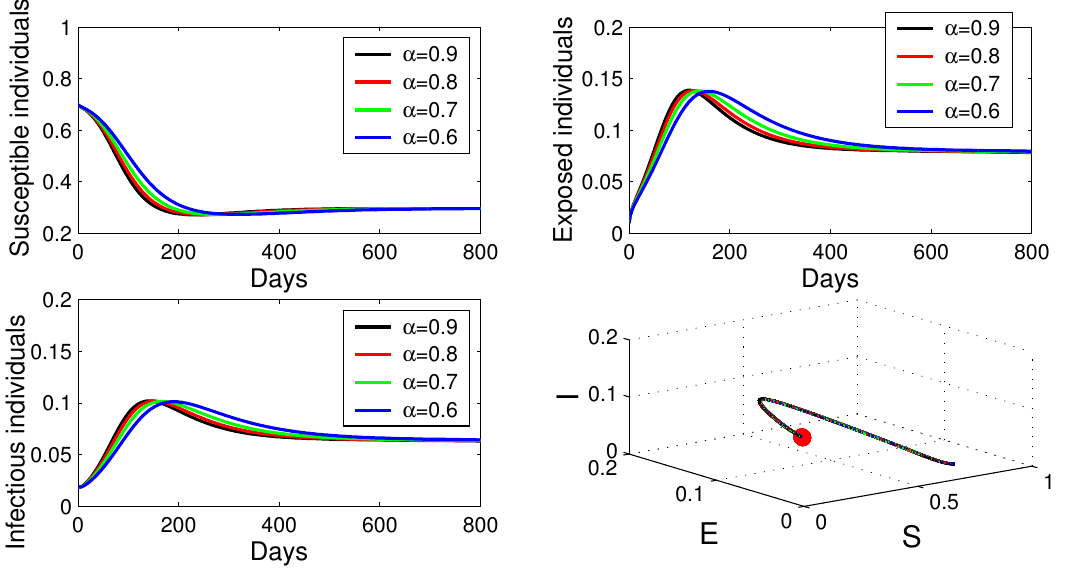
Figure 2. The numerical solution of (31) for different values of α